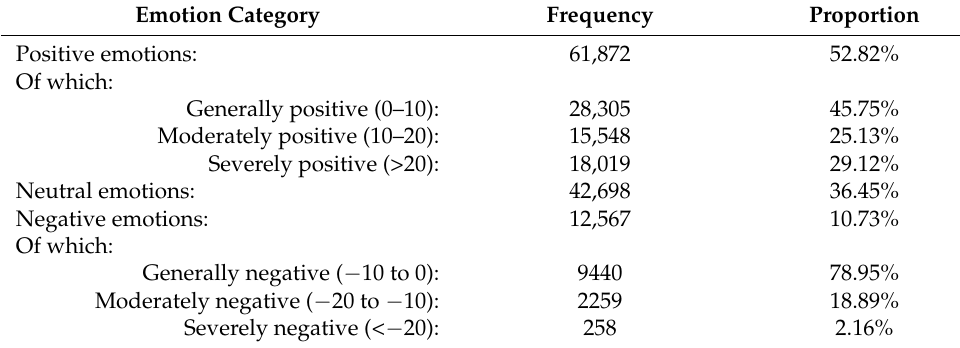
Table 3. Sentiment analysis of tourists’ perception of terraced agro-cultural